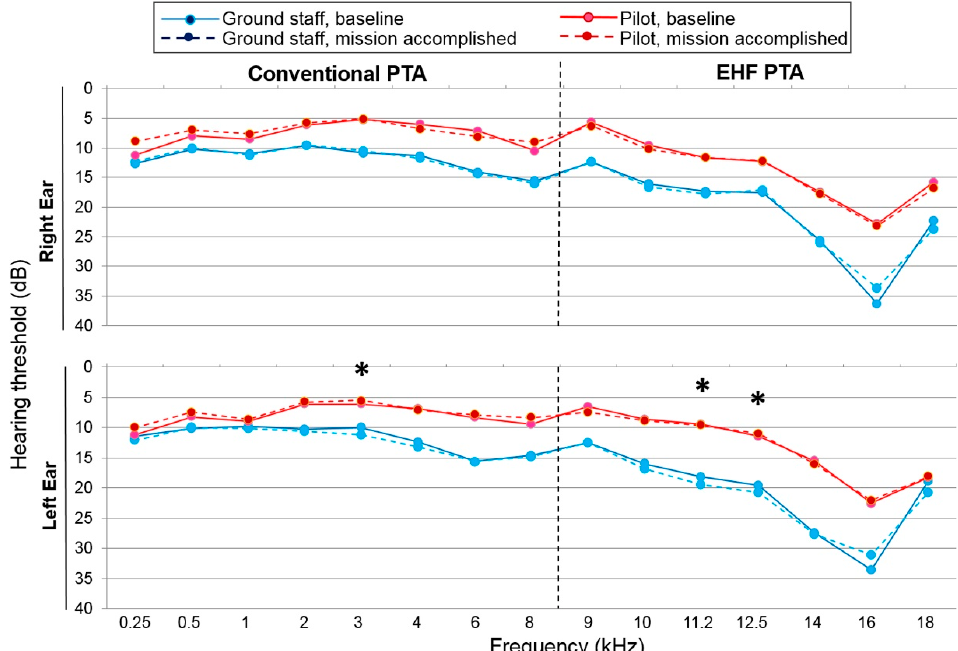
Figure 4. Mean of the conventional and EHF pure-tone audiometric hearing thresholds for both ears for the ground staff and pilot groups before and after flight mission execution. * p < 0.05 when comparing the mean hearing thresholds before and immediately after the flight mission in the ground staff using an independent t-test. PTA = pure-tone audiometry; EHF = extended high-frequency.